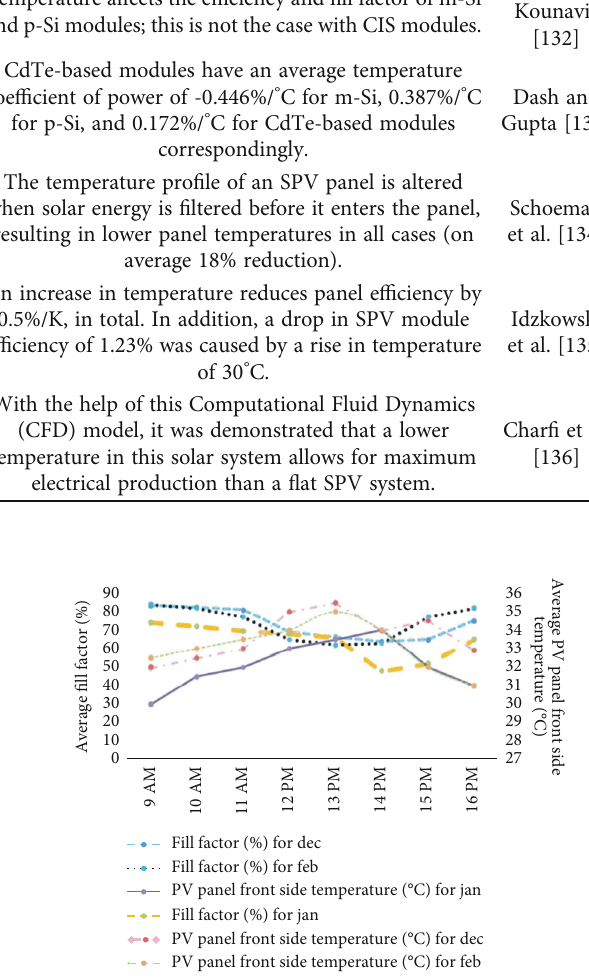
Figure 15: Performance characteristics curve for SPV system with the e ff ect of SPV panel front side temperature